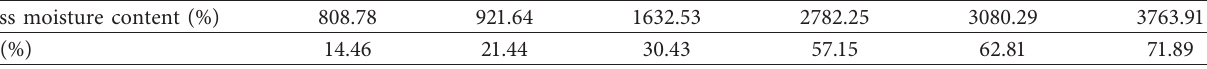
Table 7: Calculated values for the phenolic insulation board. Mass moisture content (%)